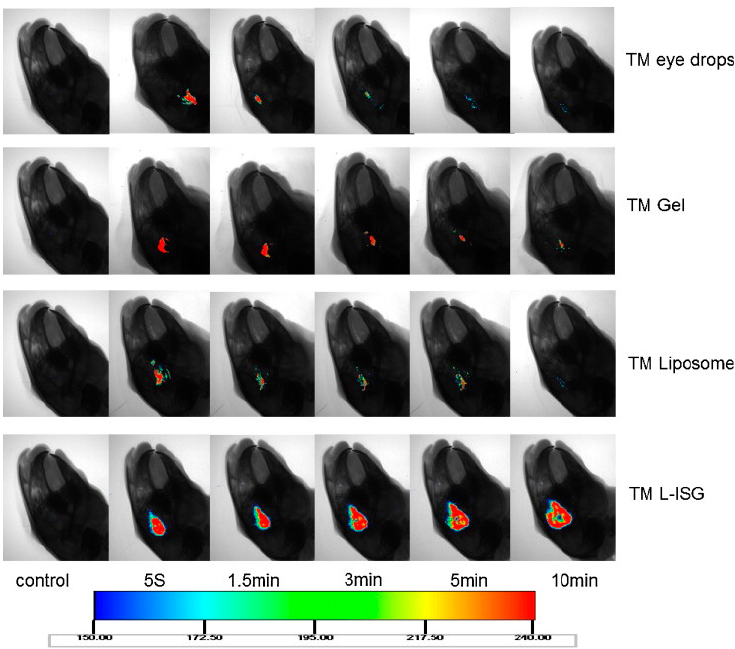
Figure 9. In vivo real time fluroscence imaging of timolol maleate (TM) eye drops, gel, liposomes and composite system (TM L-ISG). Recovery of TM on the corneal surface at 5 s, 1.5, 3, 5 and 10 min post-application. Reprinted from [162]. Copyright (2018), with permission from